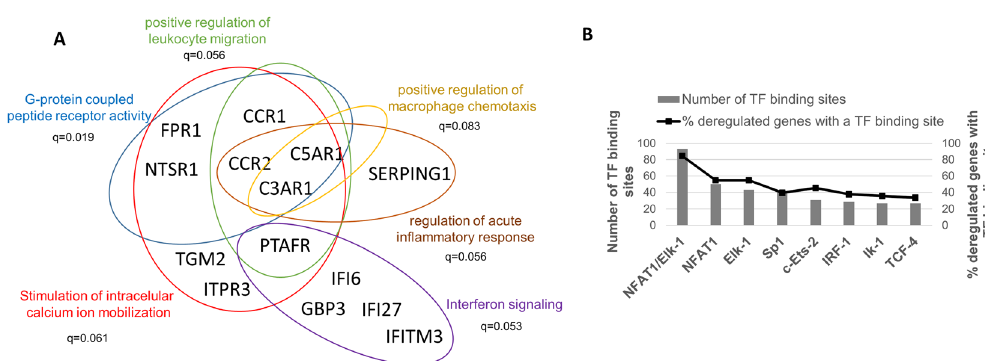
Figure 4. EC-LTNP versus TP-ART comparison. Gene Ontology terms statistically significant in the comparison EC-LTNP versus TP-ART (FDR corrected p-values < 0.1) ( A ). The promoter sequences of the genes differentially expressed between EC-LTNP and TP-ART were inspected to identify putative transcription factor binding sites using PROMO algorithm in ALGGEN server. The total number of transcriptional factor binding sites found and the percentage of these genes with a concrete binding site are showed ( B